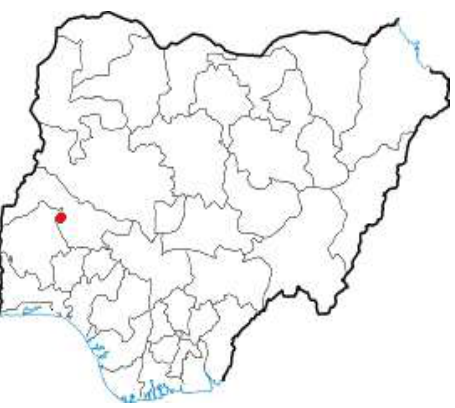
Figure 2. Map of Nigeria showing